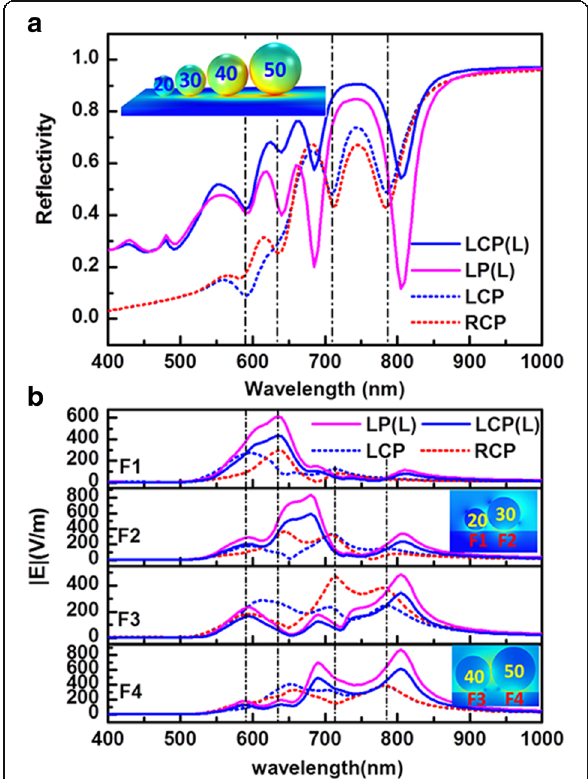
Fig. 8 Comparison with linearly arranged particles by different polarized light. a Reflectance spectra of different silver particle-film system. The blue and pink solid lines represent the reflectance spectra of the linear silver particle chain-film system excited by left- hand circle light (marked as LCP(L)) and linear polarized light (marked as LP(L)), respectively. The structure of linear particle chain-film is shown in the inset. In the diagram, Arabic numerals 20, 30, 40, and 50 represent the radius of corresponding particles. b The electric field enhancement spectra in the gaps between particle-film in the chiral particle chain-film and the linear particle chain-film systems. The gaps between particle-film are respectively labeled as F1, F2, F3, and F4, which are indicated in the insets. The blue and pink solid lines represent the enhancement on the film in the linear chain structure excited by left-hand circle light (marked as LCP(L)) and linear polarized light (marked as LP(L)), respectively. The blue and red dotted lines are electric field enhancement for the chiral particle chain-film system probed by LCP and RCP light, respectively. The vertical dashed lines from left to right correspond to the peaks at 590, 635, 710, and 785 nm, respectively